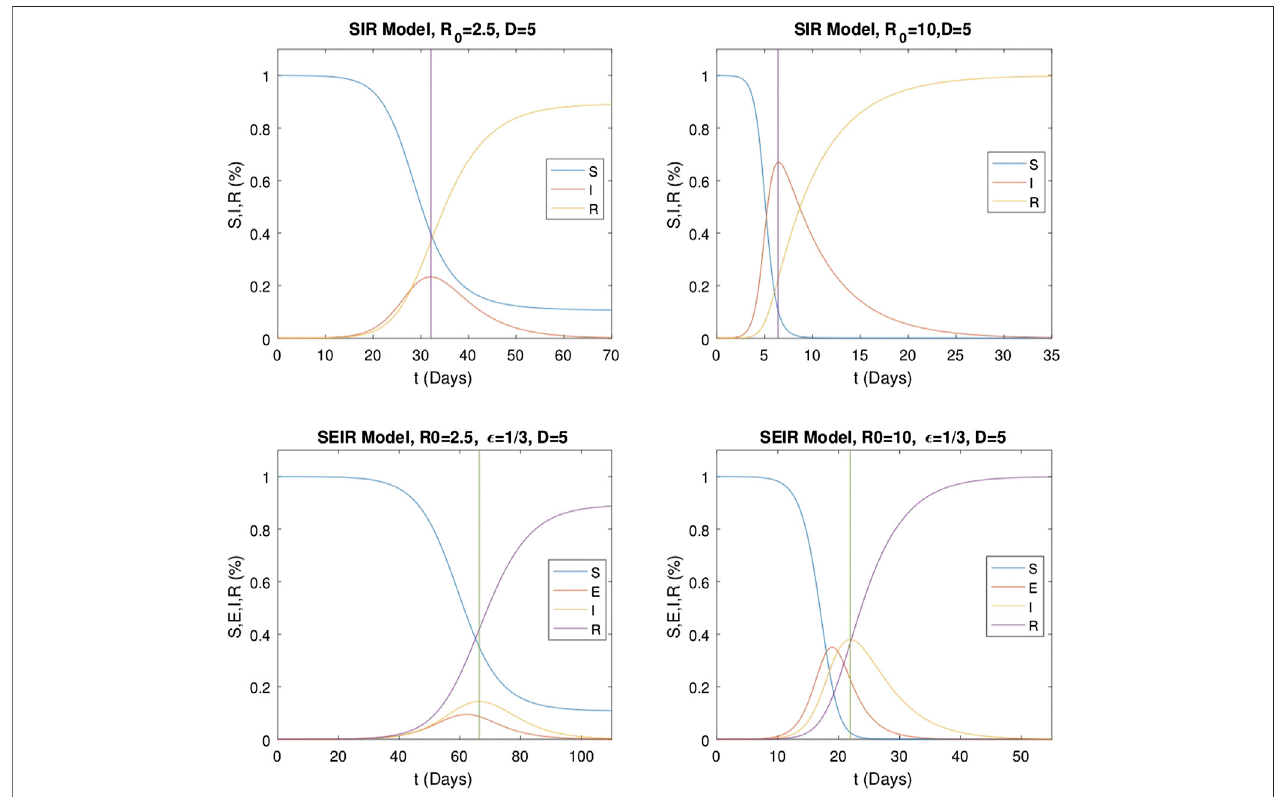
FIGURE 4 | Numerical solutions of classical SIR (1) and SEIR (2) models with R 0 (cid:2) 2 . 5 and 10. Here, ϵ and γ are chosen as 1 / 3 and 1 / 5 ( D (cid:2) 5), respectively. Time shift does not occur in classical models.